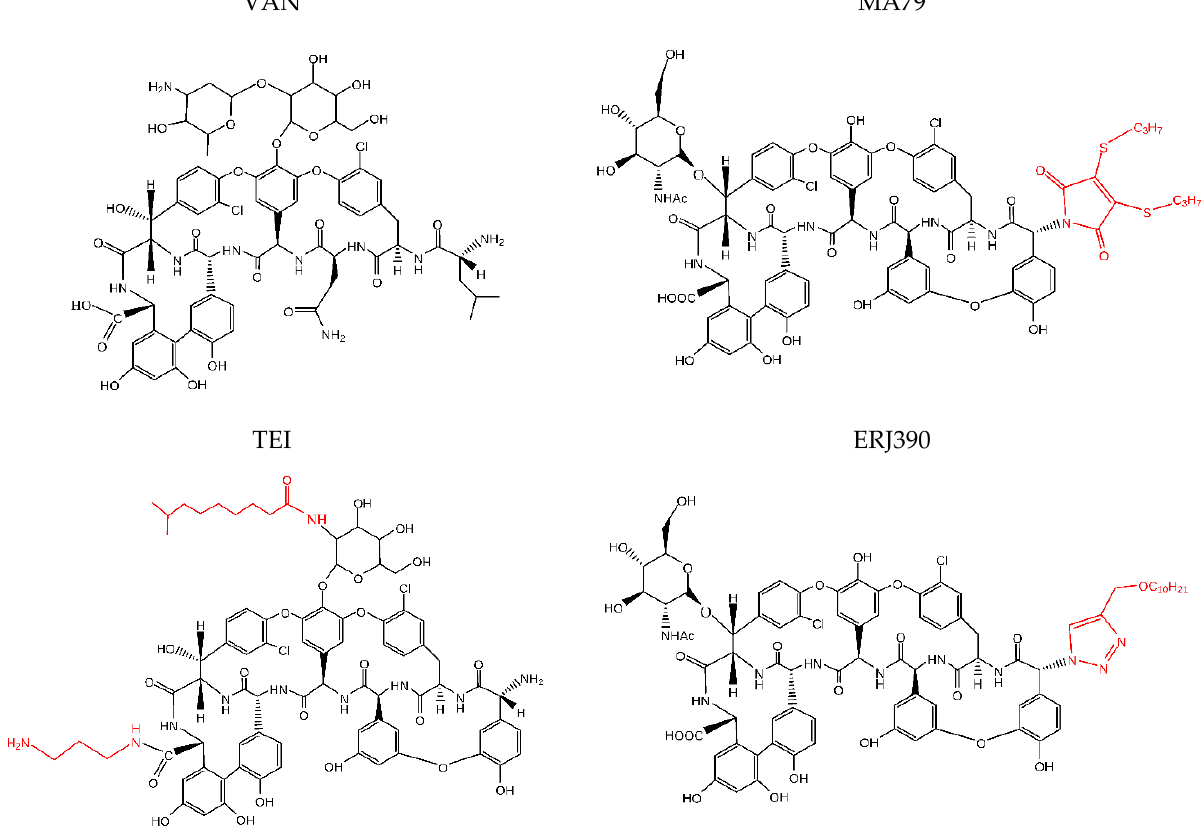
Figure 1. Chemical structures of the antibiotics: vancomycin (VAN), teicoplanin (TEI), MA79, and ERJ390. Lipophilic moieties are highlighted in red.